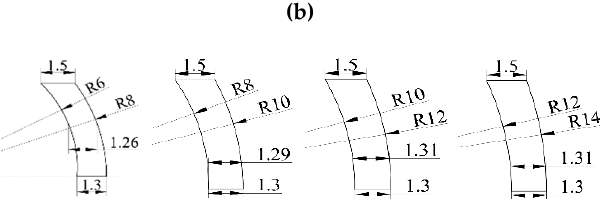
Figure 2. Structure diagram of the liner: ( a ) Structural diagram of the liner with a thickness of 1 mm at the center; ( b ) Structural diagram of the liner with a thickness of 1.15 mm at the center; ( c ) Structural diagram of the liner with a thickness of 1.15 mm at the center.